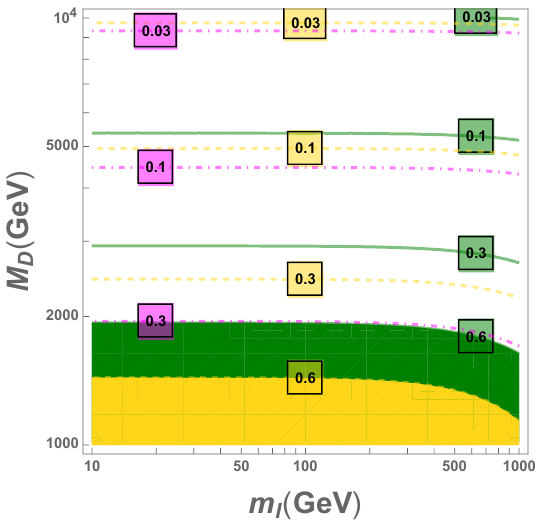
Figure 4 . A contour plot of C NP with contour lines 0 : 03 ; 0 : 1 ; 0 : 3, and 0 : 6 in the unit of 10 (cid:0) 11 GeV (cid:0) 2 1 in the ( m I ; M D )-plane for (cid:21) s (cid:21) (cid:3) = 0 : 2 and three di(cid:11)erent values of m R . The green solid (yellow b dashed, magenta dot-dashed) lines correspond to m R = 1(2 ; 3) TeV. The green and yellow region is excluded for m R = 1 TeV and m R = 2 TeV, respectively. For m R = 3 TeV, the entire region is allowed.